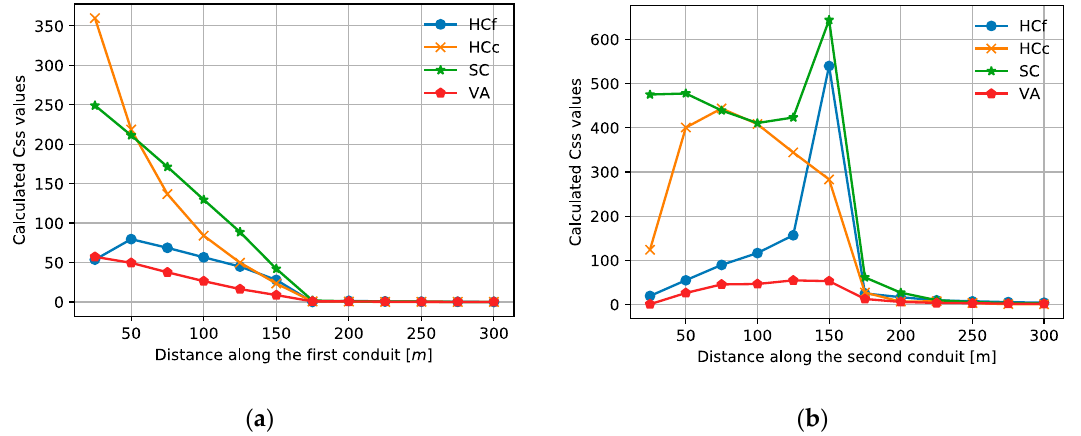
Figure 7. Calculated Css values of selected parameters at different locations along the: ( a ) First conduit; ( b ) Second conduit.